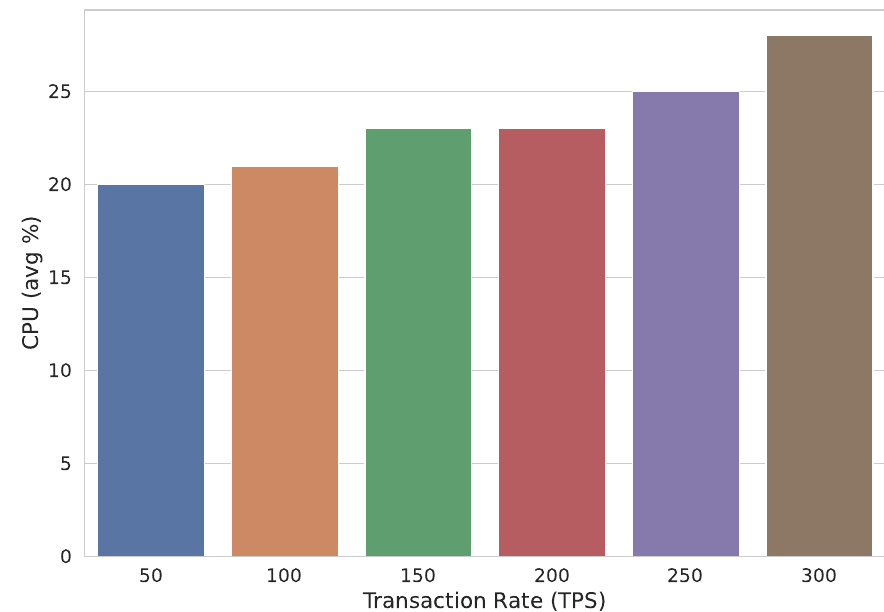
Figure 18. CPU usage with varying transaction